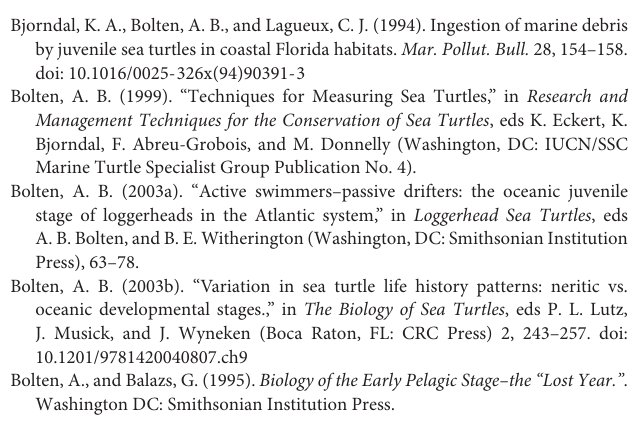
TABLE S1 | Proportion of mass and weight of ingested plastic to size and weight of corresponding 2016 and 2017 post-hatchling washbacks. TABLE S2 | Data for the type, location and total plastic ingested by each post-hatchling washback necropsied in 2016 and